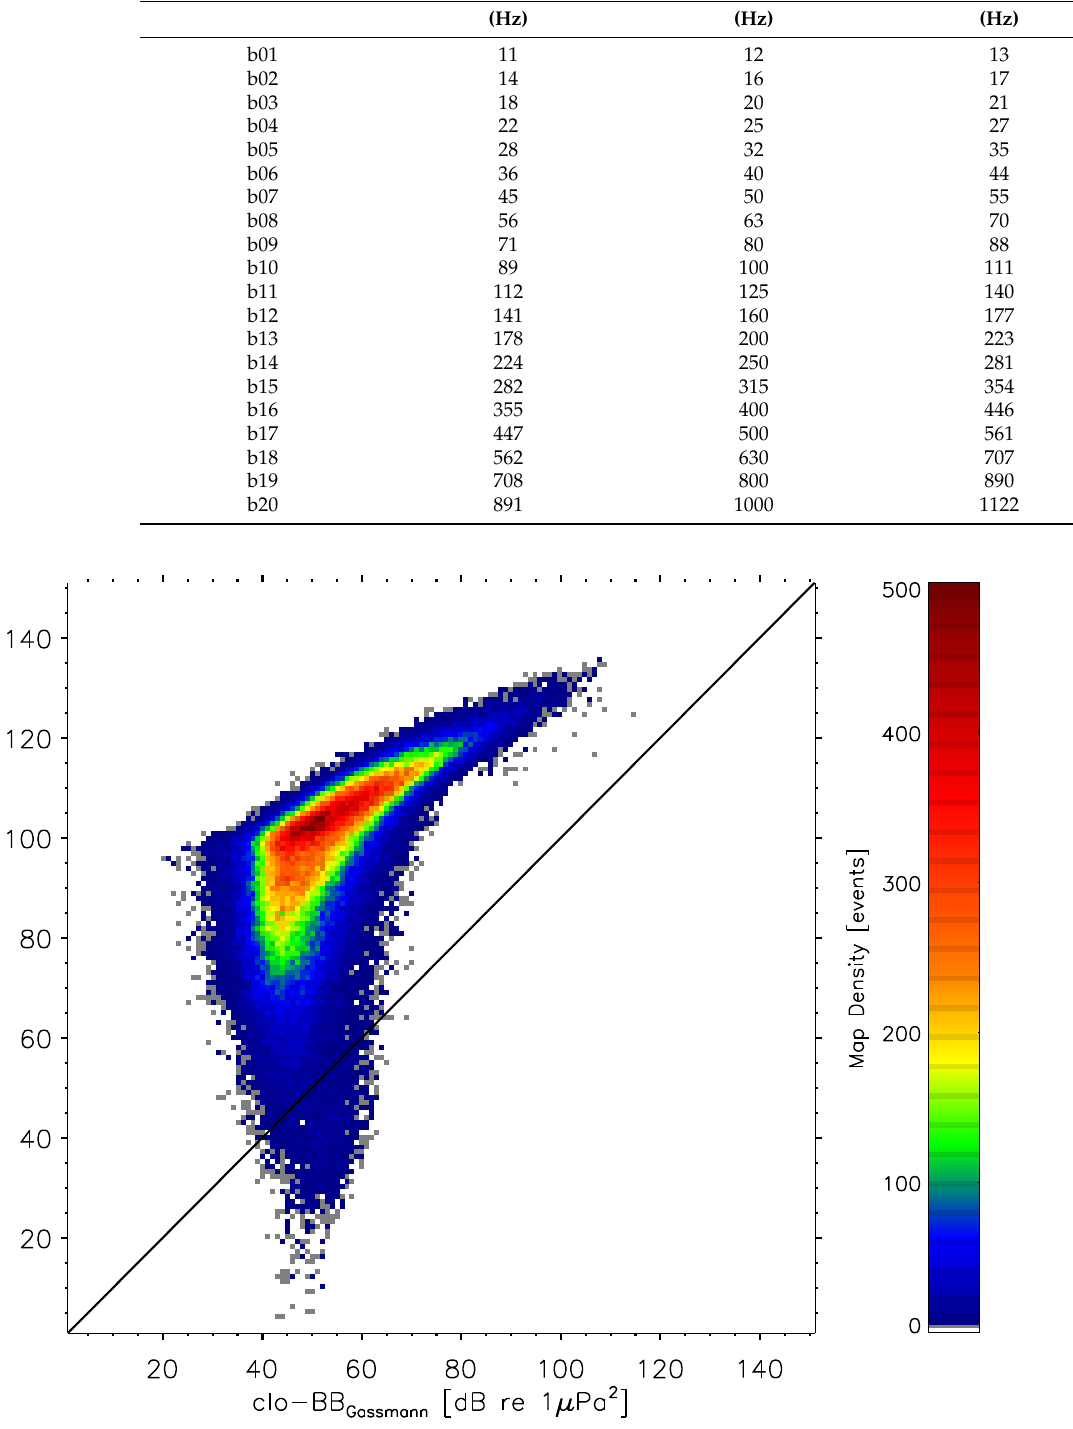
Figure 2. Density plot of the point-to-point comparison of the clo-BB Gassmann vs. clo-BB RAM pre- dictions for the GT simulation for timestep numbers between 1440 and 10,080. A total of 214,438 ship-to-animal pairs are displayed. A binsize of 1 dB was used to process the square map with colored density levels between 0 and 500